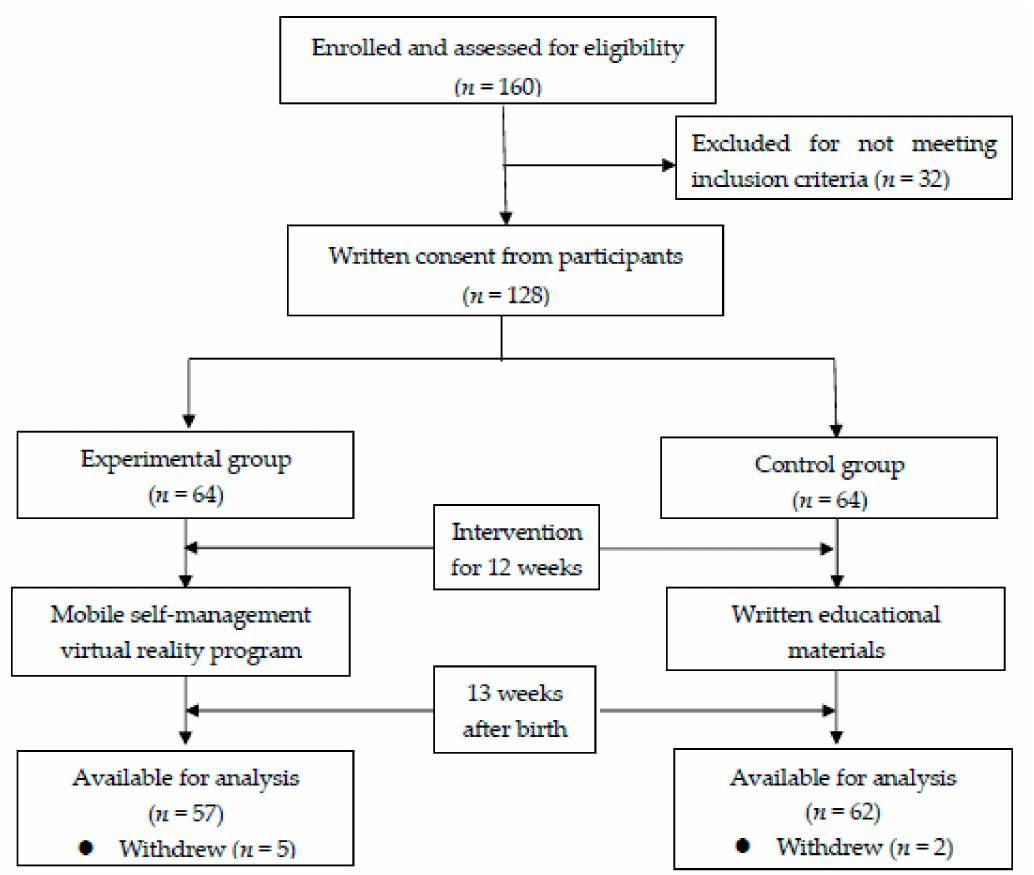
Figure 1. Flow diagram of the